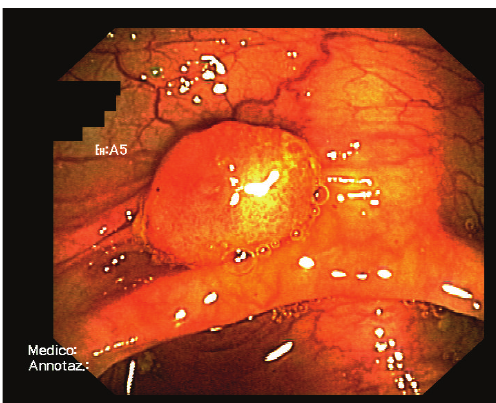
Figure 1: Conventional endoscopic image showing the dome-like lesion. A reddish rough mucosa can be seen in the top surface.